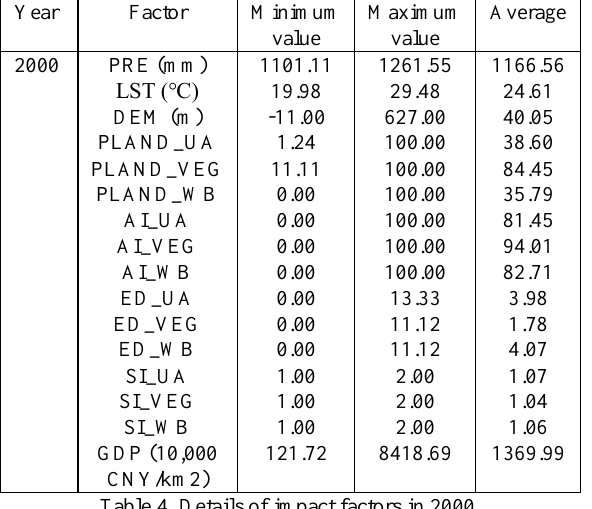
Table 4. Details of impact factors in 2000.